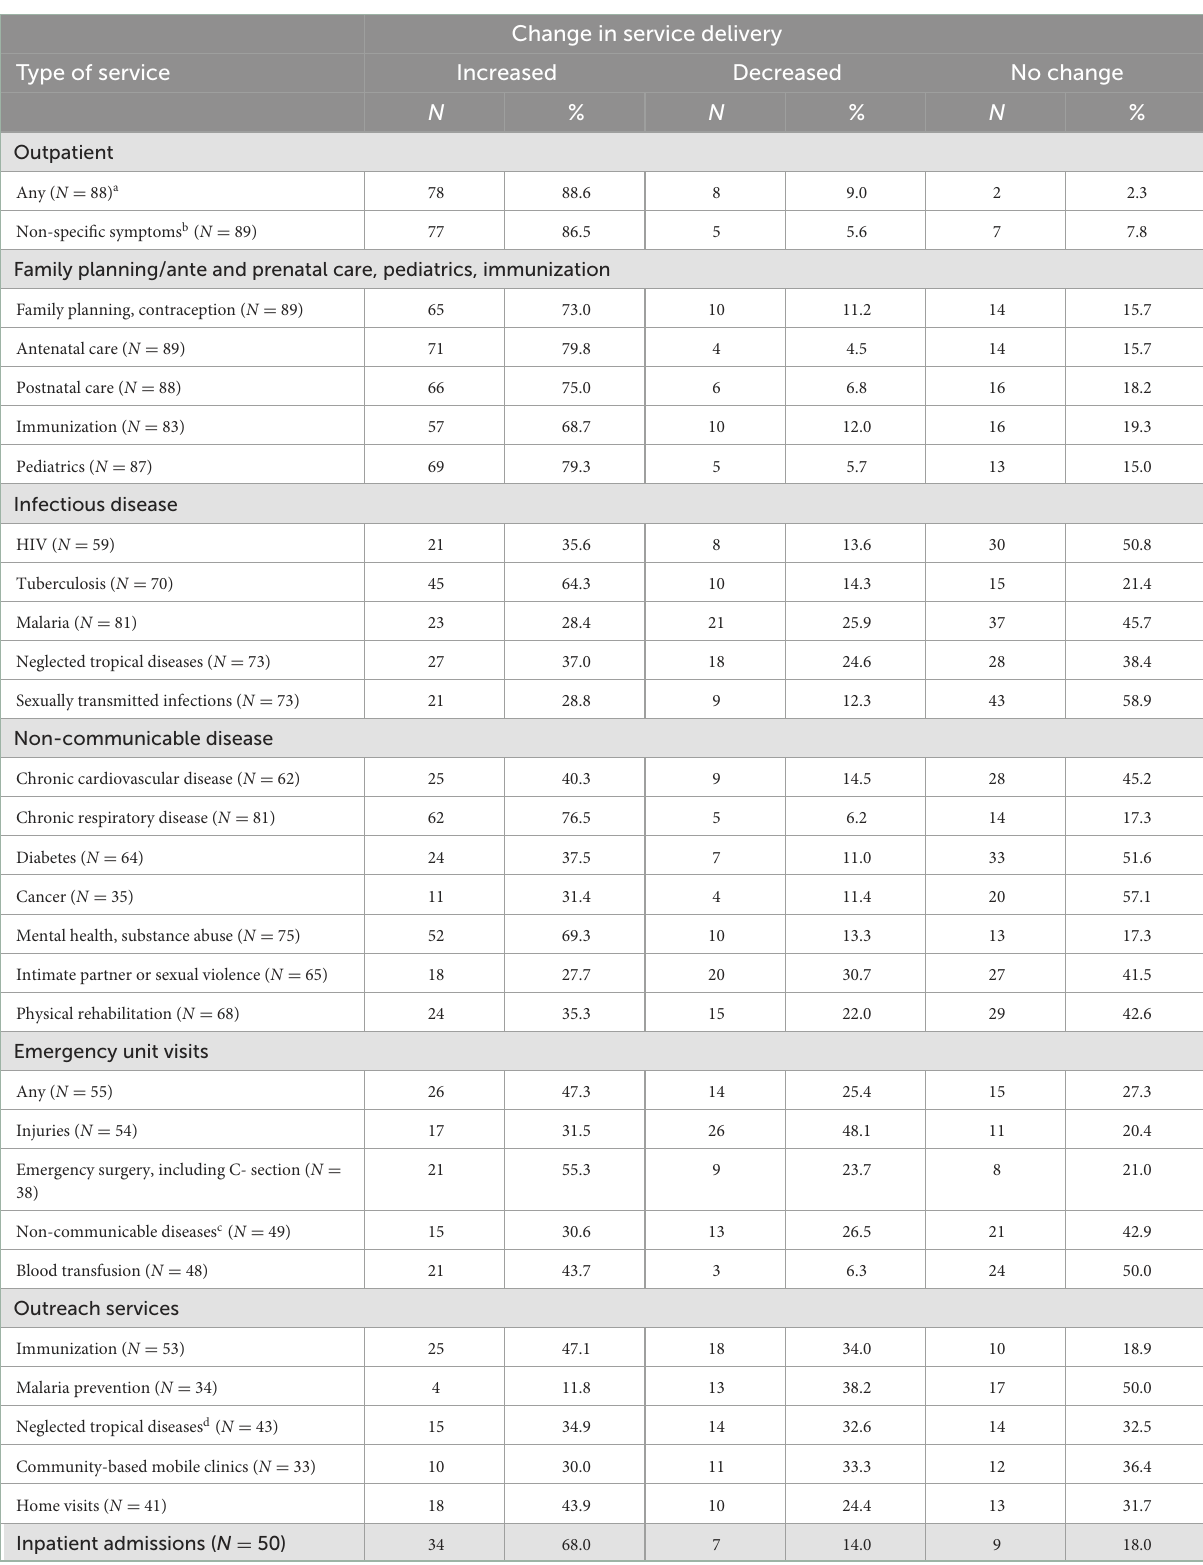
TABLE 2 Number of facilities with self-reported changes in service delivery and utilization, November 2021-Janurary 2022, compared to a year previously,